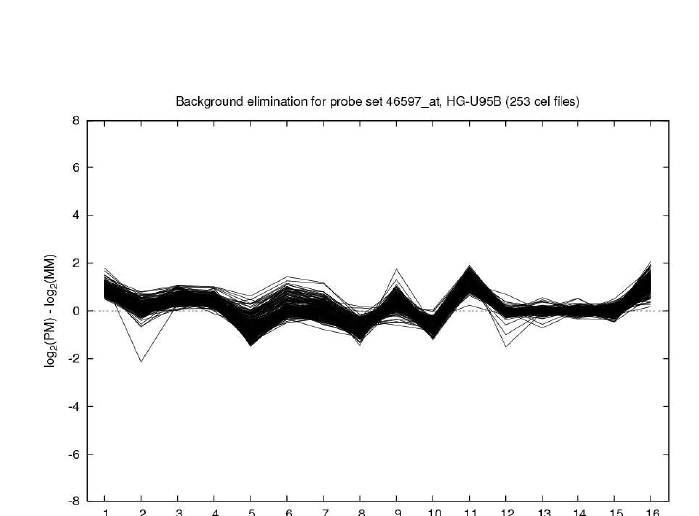
Supplementary Figure 2: Probe intensities over all cel files for probe set 46597 at on the HG U95B array (A) Perfect match intensities (log scale) (B) ADAPT probe positions on the transcripts (C) Background elimination (log 2 (PM) - log 2